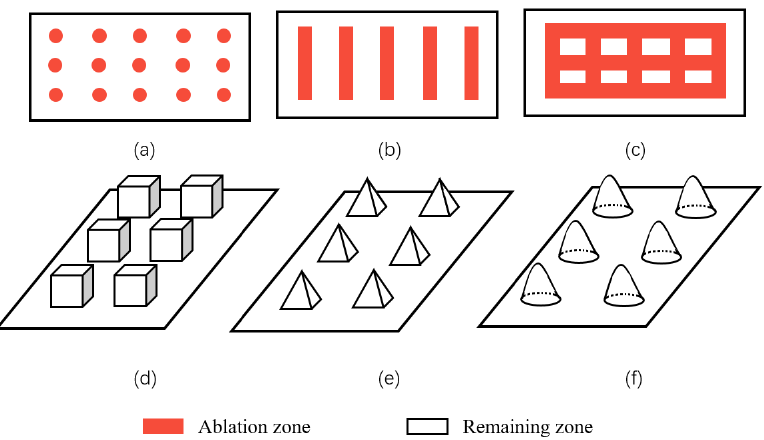
Figure 21. Common surface structures: ( a ) spot structure, ( b ) groove structure, ( c , d ) grid and cubic prism structure, ( e ) cubic pyramid structure, and ( f ) mastoid structure.